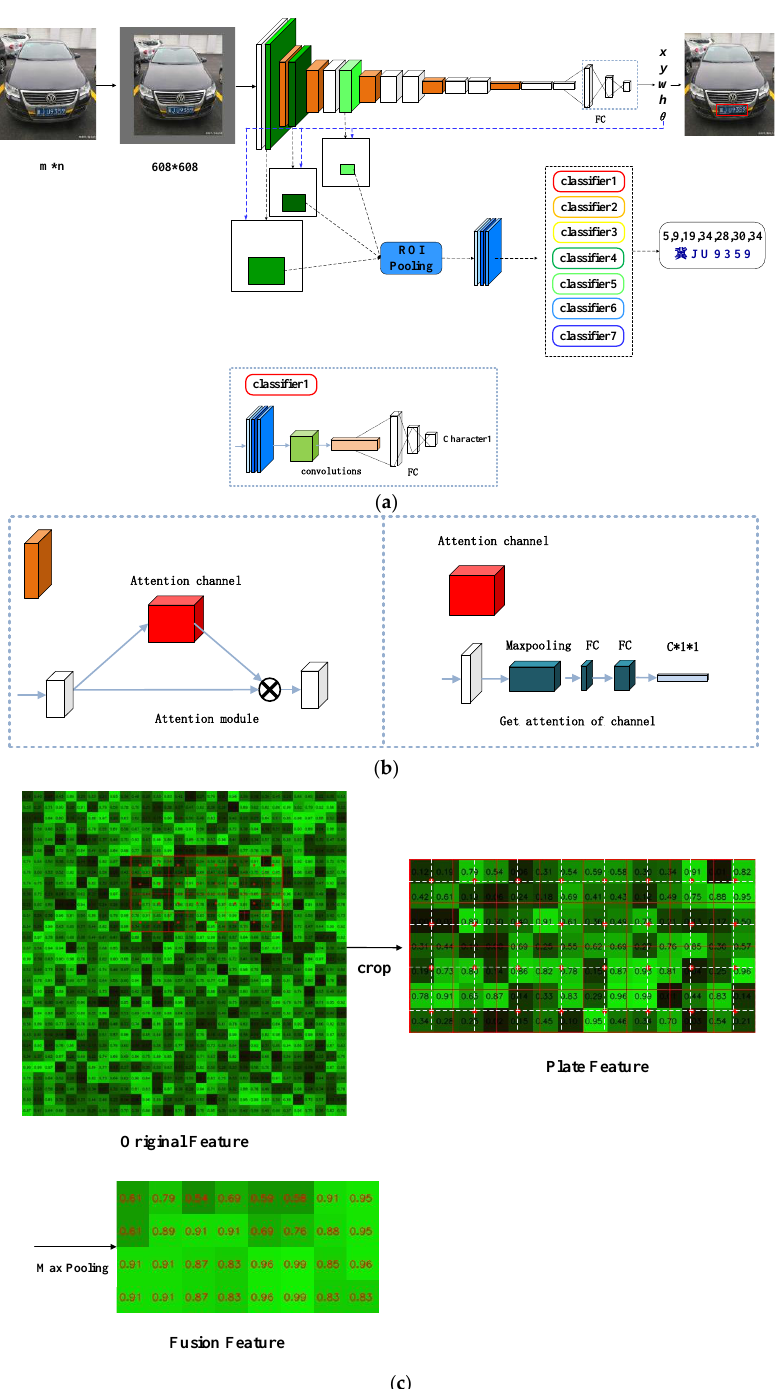
Figure 2. End-to-end light license plate detection and recognition network architecture. ( a ). Network structure diagram beginning with network input and ending with license plate position and character output. x and y are abscissa and ordinate. w and h are the width and height of bounding box. θ is the rotation angle of bounding box. ( b ). Attention mechanism ( c ). Region-of-interest (ROI) pooling, the red line divides LP into several regions, the red circles are the ROI centers of several regions. The white dashed line divides every small ROI region into four small regions. The maximum value within each small ROI region is calculated using bilinear interpolation. Then the maximum values of the four small ROI regions synthesize the red final maximum value.